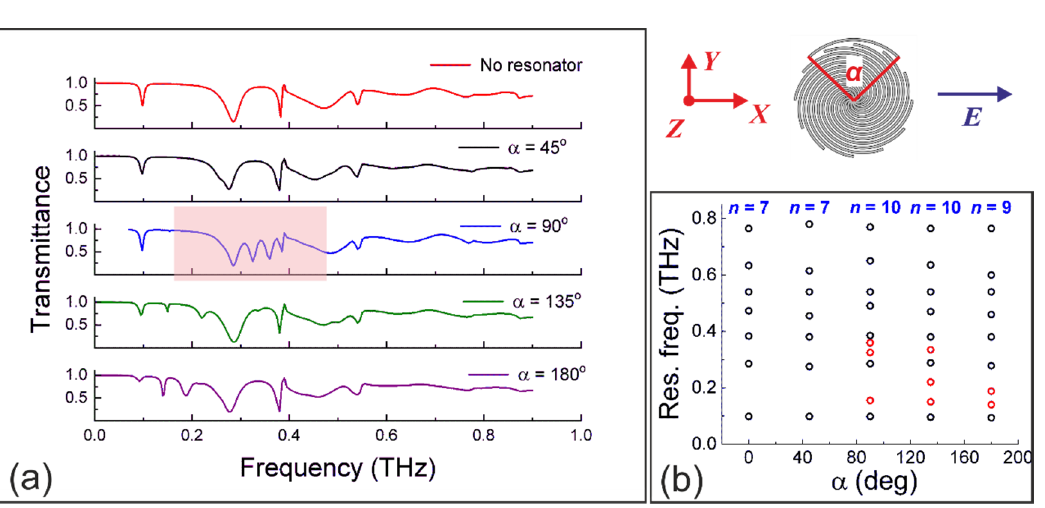
Figure 3. TM-transmittance spectra of the distantly spaced spiral disks with a 90° C-resonator under oblique illumination: θ = 0, 20 and 40°: ( a ) the simulations and ( b ) the experiments. Azimuthal angles ϕ = 0 and ϕ = 90° correspond to the zero projections of the incident E -field on the Y and X axes, respectively.